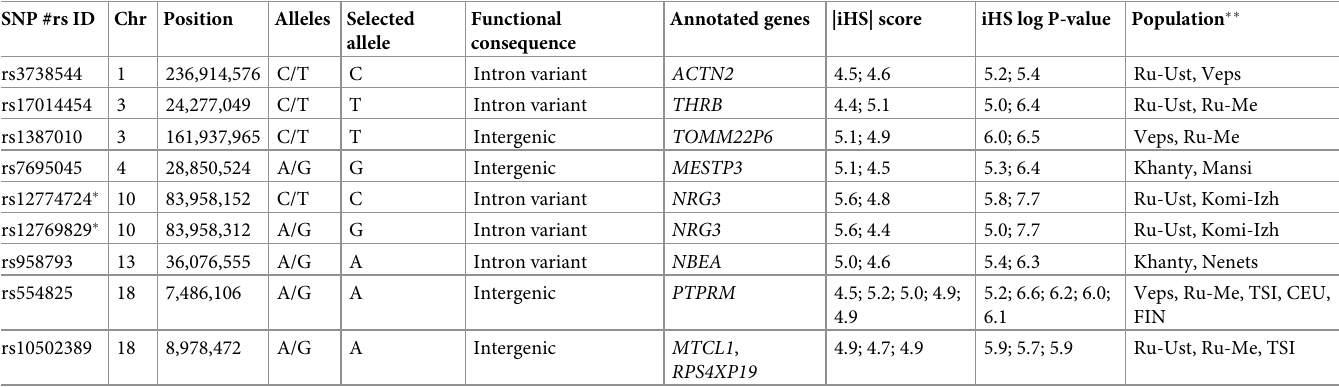
Table 1. SNPs with significant (p � 1 x 10 − 5 ) iHS scores found in populations